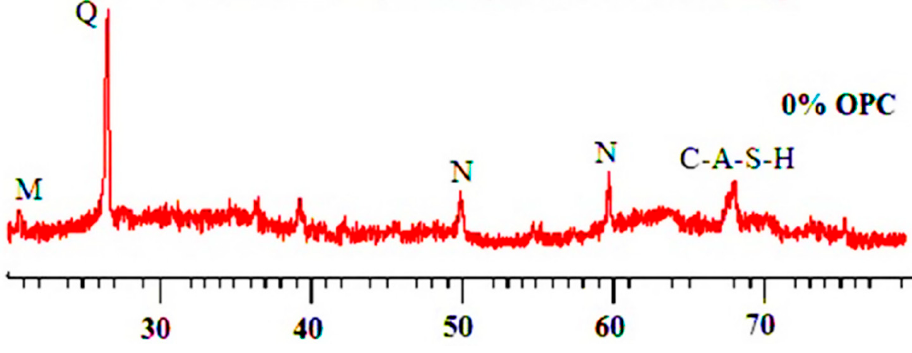
Figure 19. XRD of geopolymer concrete [86].